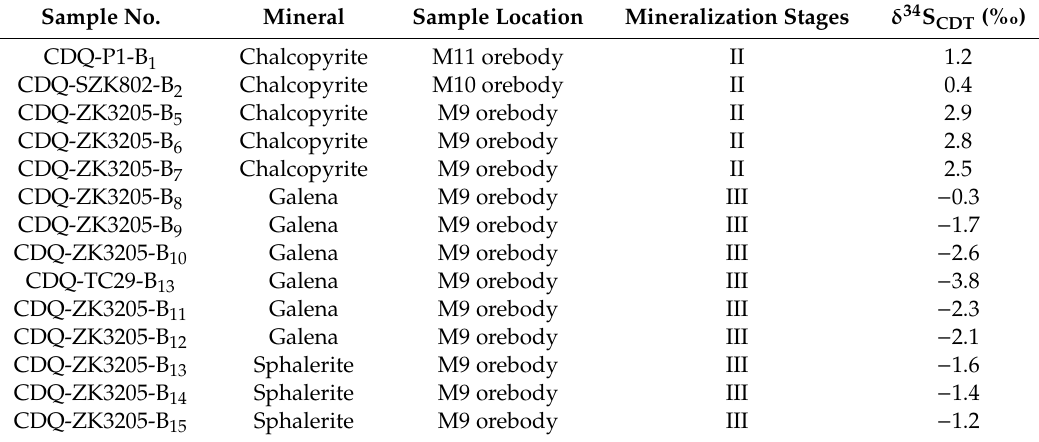
Table 5. Sulfur isotopic compositions of the Chuduoqu Pb-Zn-Cu deposit. Sample No.